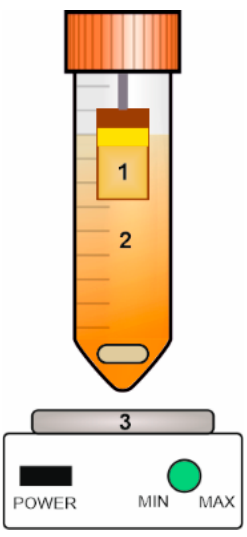
Figure 1. Schematic representation of the inoculation process, where: 1—colonized surface; 2—MRS Broth medium containing bacteria inoculum (OD = 1); 3—magnetic